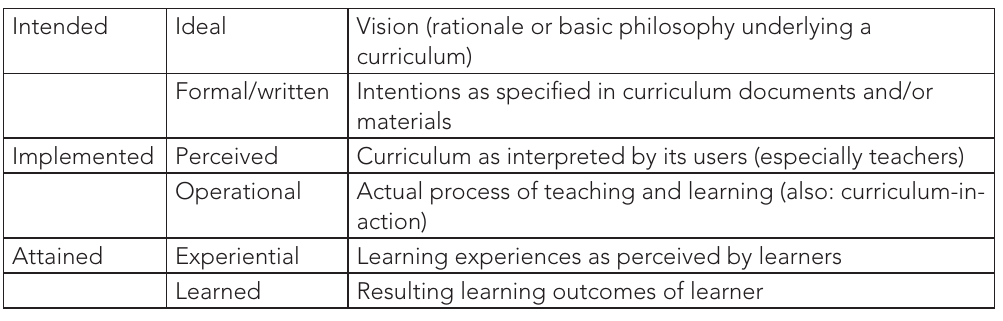
Table 1: Typology of curriculum representations (van den Akker, 2003: 3)